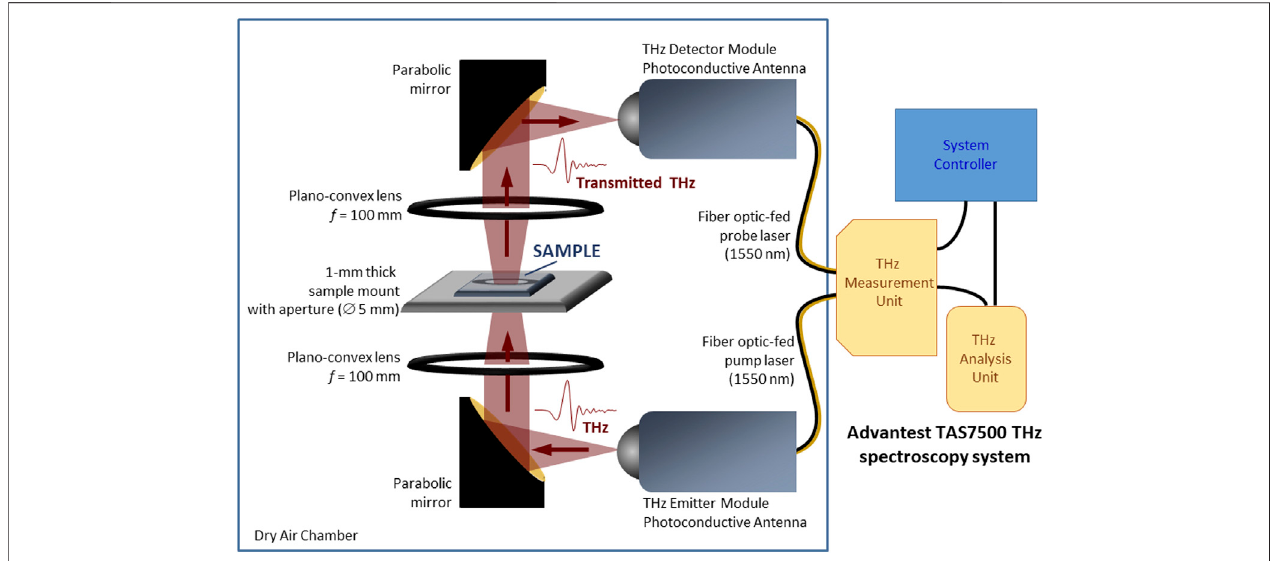
FIGURE 1 | The transmission terahertz time-domain spectroscopy (THz-TDS) system used for investigating the transmittance of the hybrid perovskite samples (This schematic is not drawn to scale.)